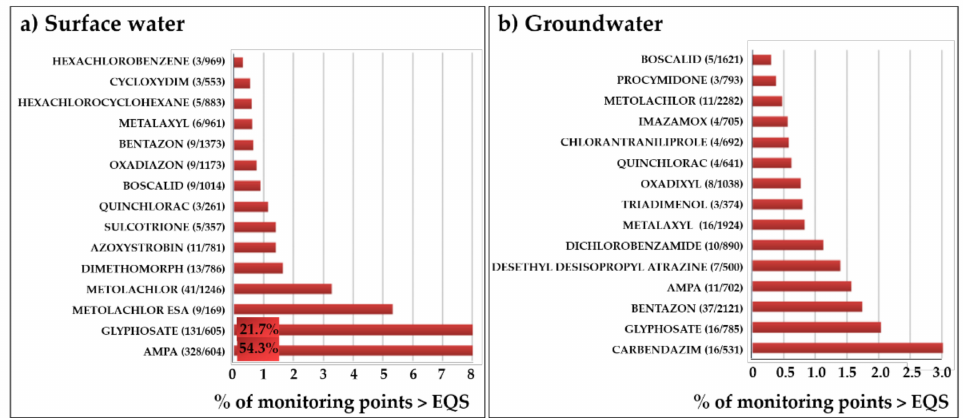
Figure 3. Most frequently detected substances above the environmental quality standard (EQS) at monitoring points in Italy, in 2018 for surface water ( a ) and groundwater ( b